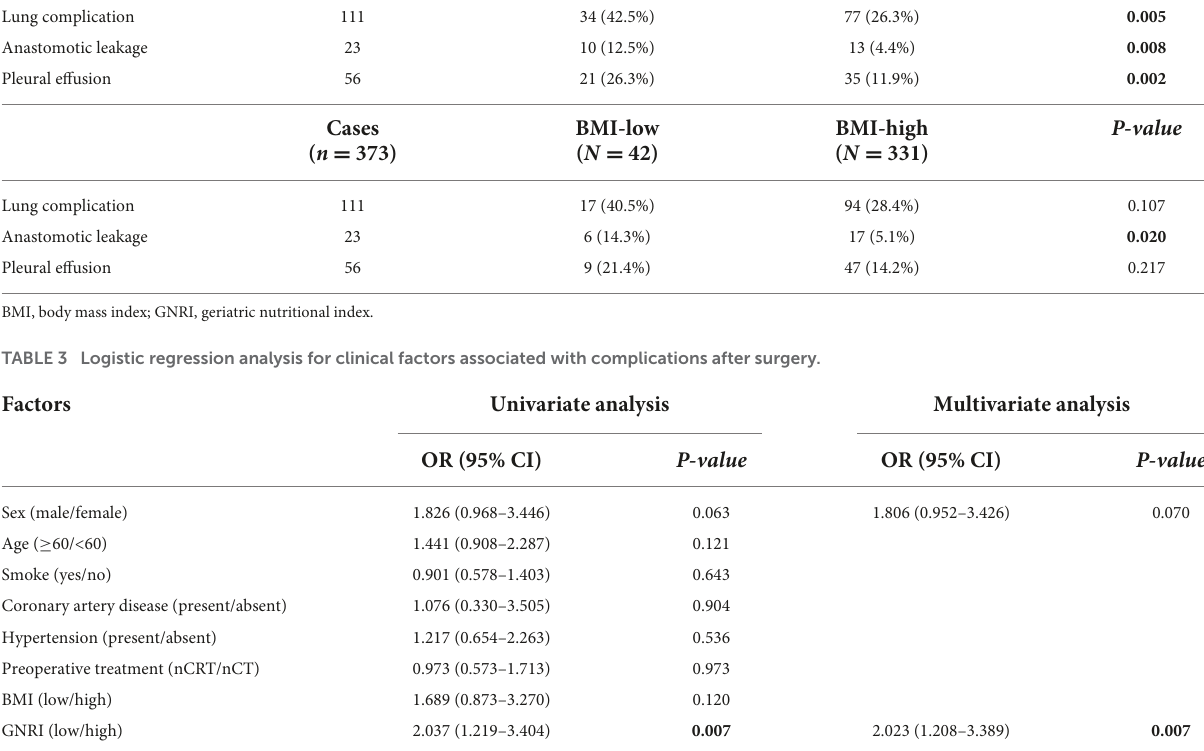
Cases GNRI-low ( n = 373) ( N = 80)